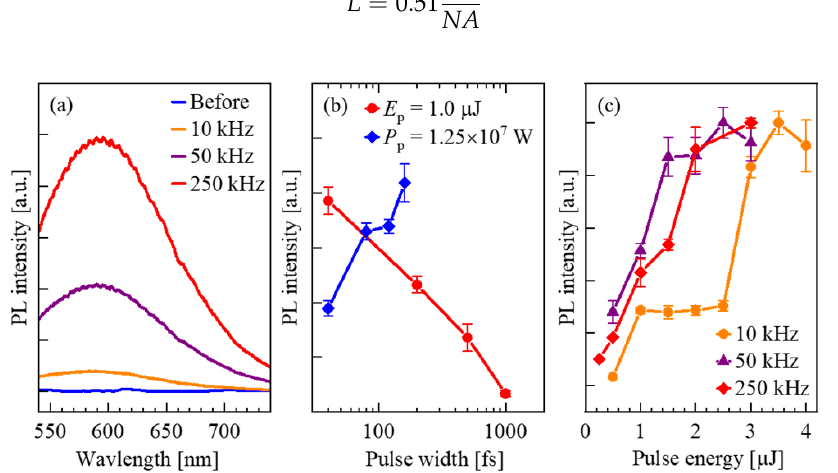
Figure 5. ( a ) Photoluminescence (PL) spectra of the crystallized regions induced by the femtosecond laser pulses with various pulse repetition rates. The laser parameters were as follows: 800 nm, 40 fs, 1.0 µ J, 0.80 NA. For irradiating the same number of pulses per unit area, the writing speed was adjusted. ( b ) Pulse width dependence of the PL intensity in the crystallized region. The E p or the P p was set to be 1.0 µ J, 1.25 × 10 7 W, respectively. ( c ) Pulse repetition rate dependence of the PL intensity as a function of the pulse energy. The pulse width was set to be 40 fs.